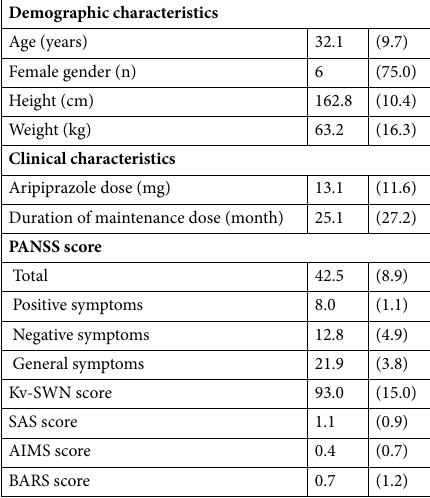
Table 1. Demographic and clinical characteristics of patients. All variables are presented as mean (± SD), or n (%). PANSS Positive and Negative Syndrome Scale, Kv-SWN Korean version of Subjective Well-Being under Neuroleptics Scale-Short form, SAS Simpson–Angus Scale, AIMS Abnormal Involuntary Movement Scale, BARS Barnes Akathisia Rating